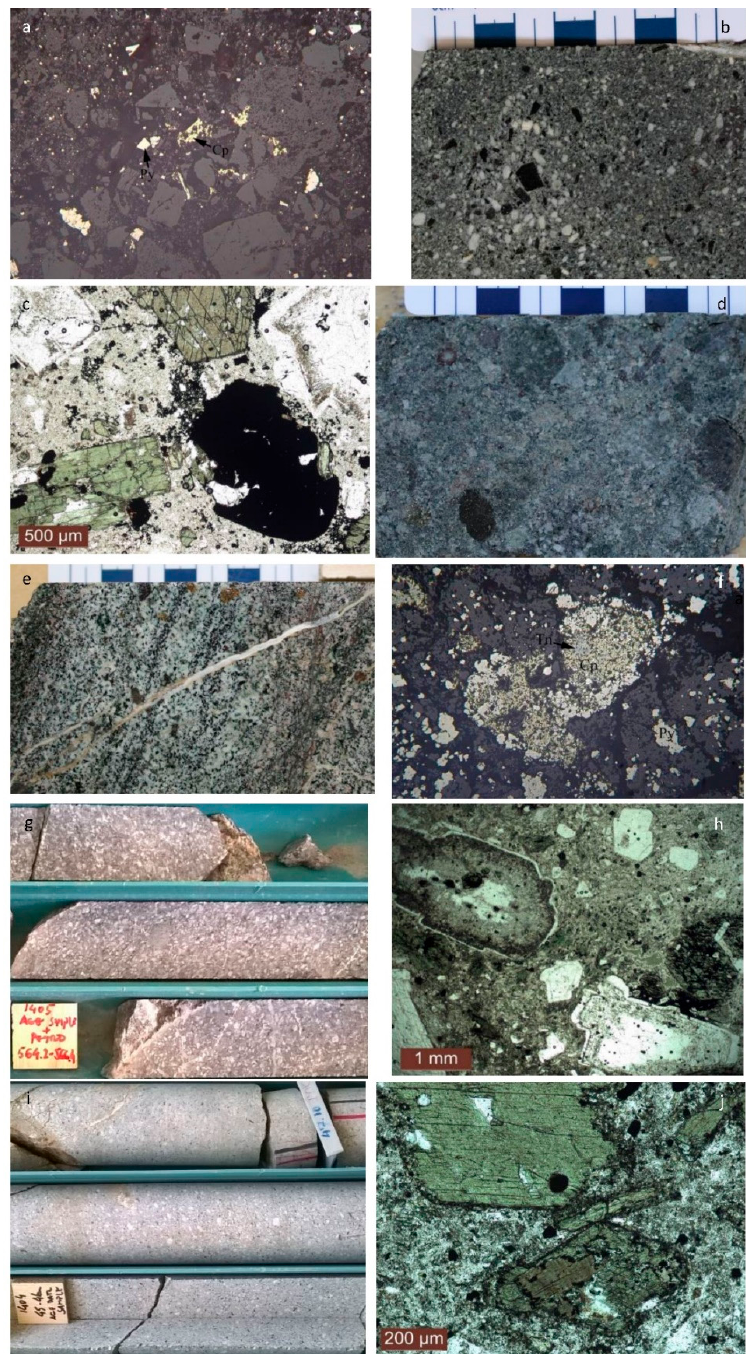
Figure 5. Petrographic characteristics of the studied drill-cores from Nikoli č evo: ( a ) pyrite (Py) and chalcopyrite (Cp) disseminations in rare mineralized clasts in V1B andesitic breccia (reflected light); ( b ) macroscopic appearance of fresh monomictic, autoclastic andesitic breccia V1B; ( c ) photomicrograph of andesite V1B (transmitted light, parallel nicols); ( d ) polymictic epiclastic andesite breccia composed of altered and mineralized clasts of V1A andesite; ( e ) layered epiclastic sandstone of V1A andesite; ( f ) photomicrograph of a mineralized V1A andesite clast in epiclastic breccia (reflected light); ( g ) drill-cores of weakly altered coherent V1A andesite; ( h ) photomicrograph of weakly-altered V1A andesite (transmitted light, parallel nicols); ( i ) drill-cores of coherent V1A andesite (shallow intrusion?); ( j ) photomicrograph of V1A andesite (shallow intrusion?) (transmitted light, parallel nicols); (a–h) drill hole RTN 1405; (i,j) drill hole RTN 1404.